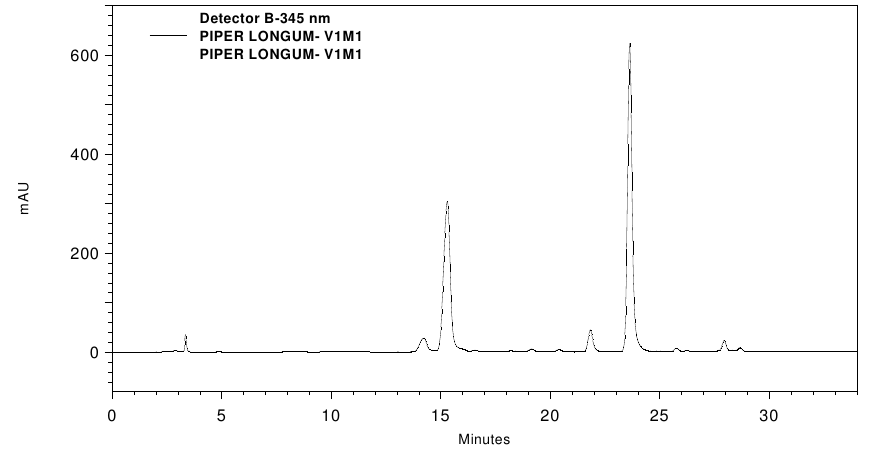
Figure 3 . HPLC chromatogram of root of Piper longum Li nn.